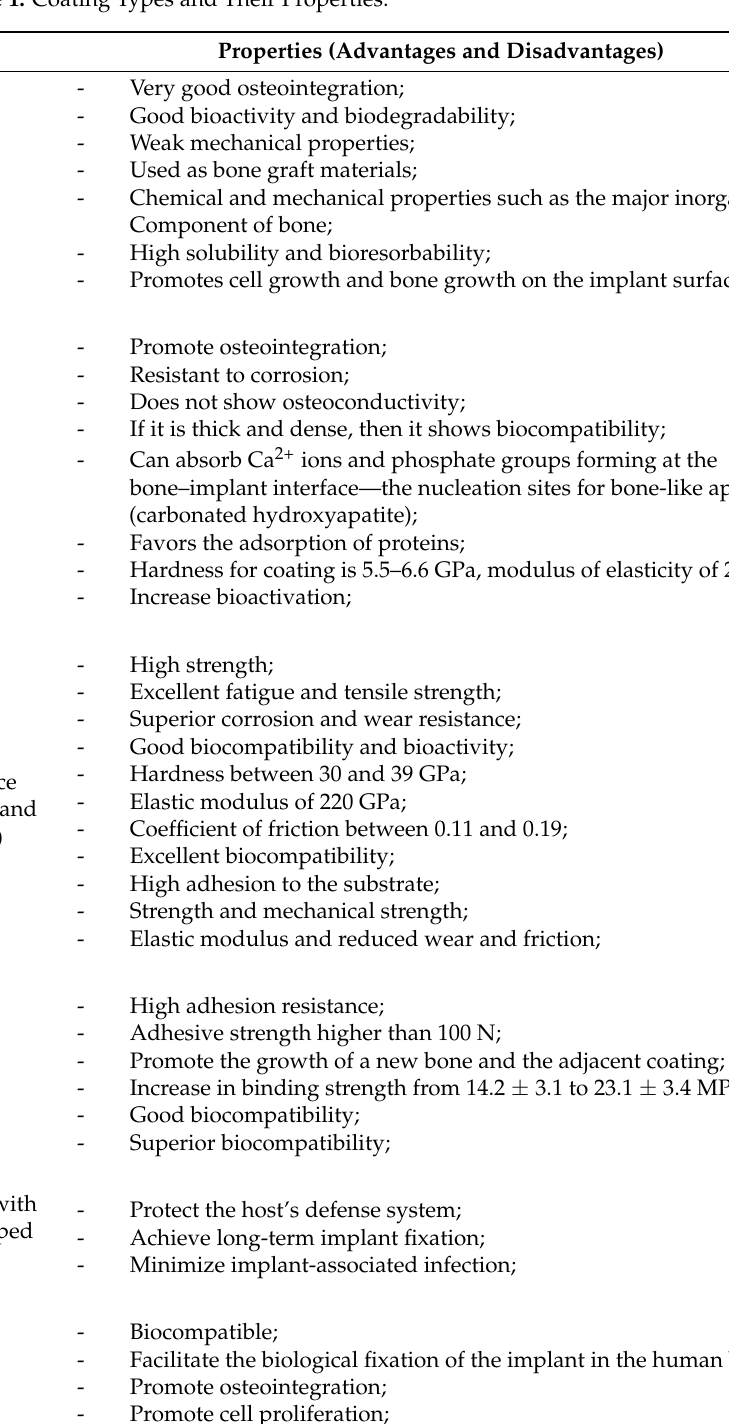
Table 1. Coating Types and Their